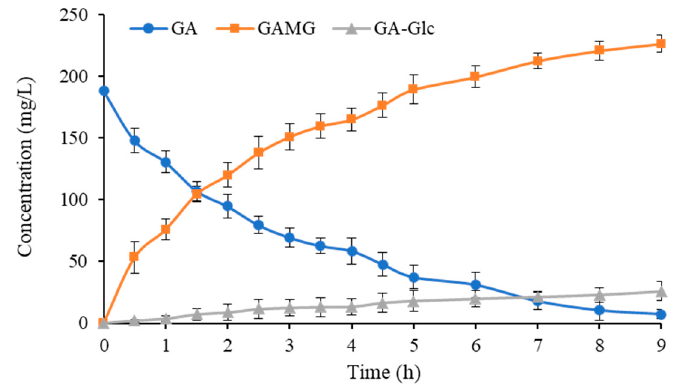
Figure 7. Time course of glycosylation of GA into GAMG and GA-Glc in the enzyme module system. The cascade reaction contained 1 mM UDP, 750 mM sucrose, 0.5 mM NAD + , 5 mM DTT, 0.4 mM GA, 5 mM pyruvate, 50 mM Tris-HCl (pH 6.5), 150 mU/mL AcSuSy, LDH, UGT, and 300 mU/mL UGDH and was performed at 35 °C and 150 rpm for 9